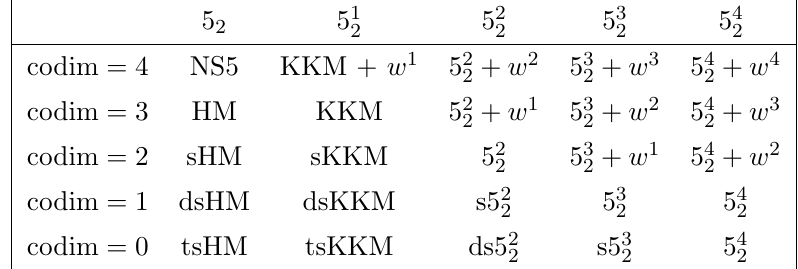
Table 1 . Various (cid:12)ve-brane solutions obtained in this section. The notation in this table is as follows: \HM" refers to as the H-monopole, and \KKM" refers to as the KK-monopole: \s", \ds" and \ts" are abbreviations of \smeared", \doubly smeared" and \triply smeared", respectively. Also, the n -winding dependence is written as w n . For the notation of the b c We have also obtained the T-duality chain starting from the space-(cid:12)lling (cid:12)ve-brane